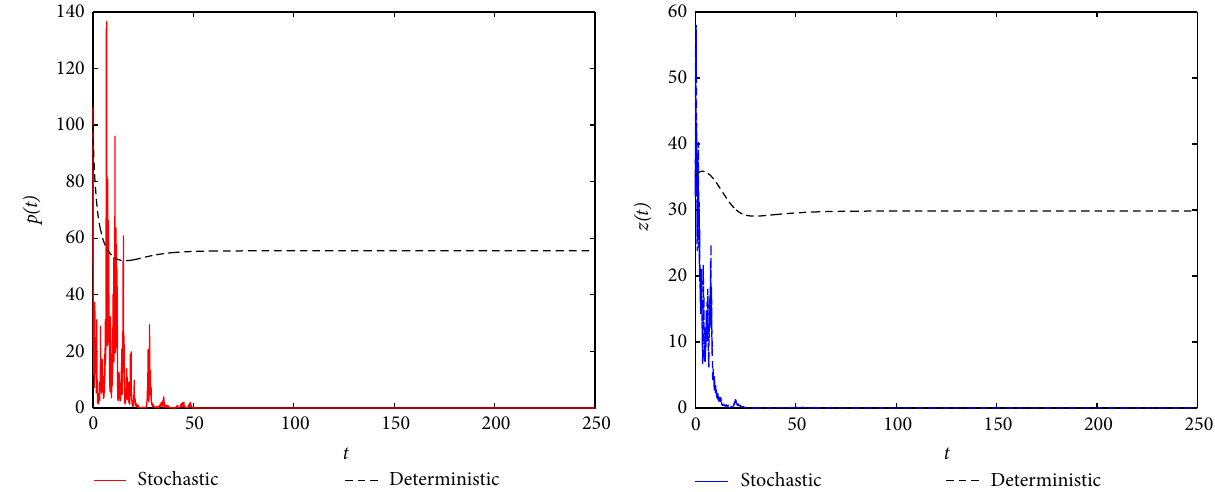
Figure 1: The solutions of system (2) and its corresponding deterministic system with 𝜎 Eq.